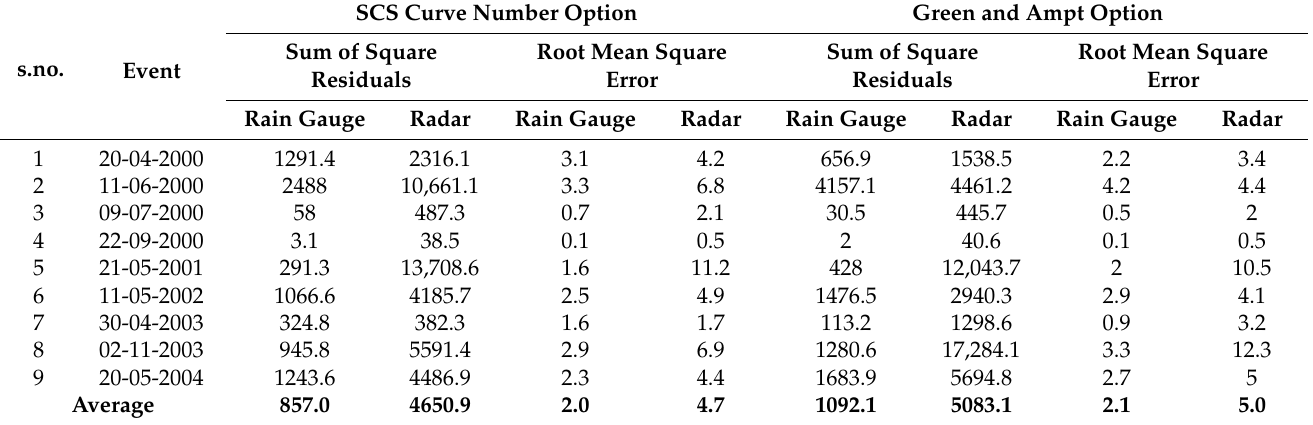
Table 10. Statistical comparison of modeling results obtained using SCS curve number and Green and Ampt runoff